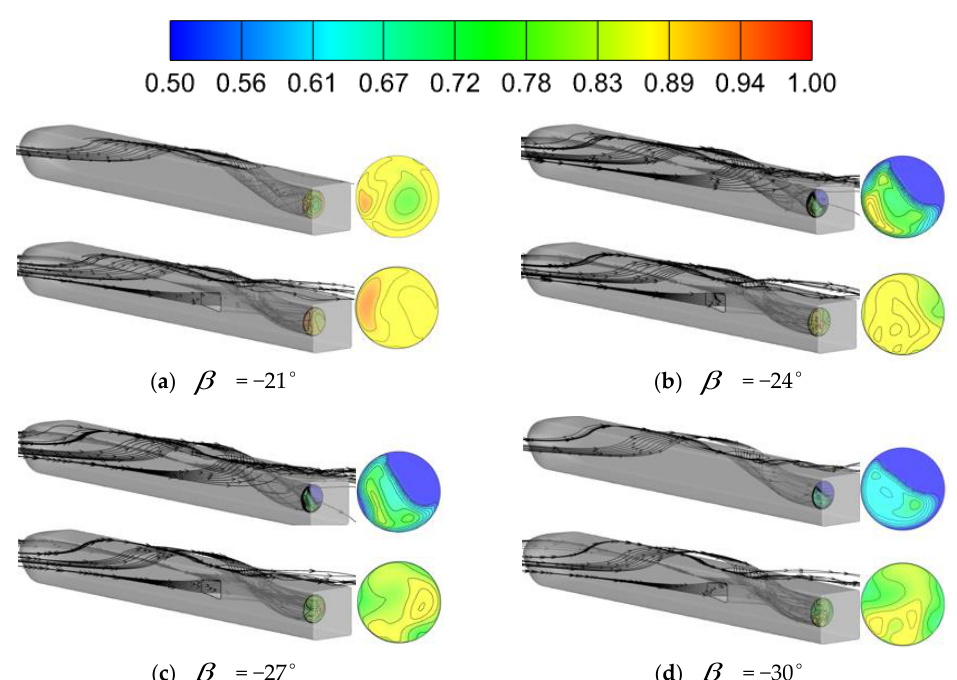
Figure 12. Flow characteristics of inlet under typical sideslip angles.